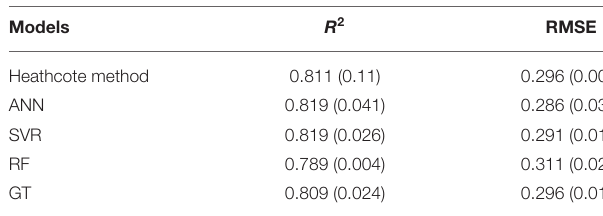
TABLE 9 | ML methods comparison against the Heathcote method results in a 5-fold cross validation